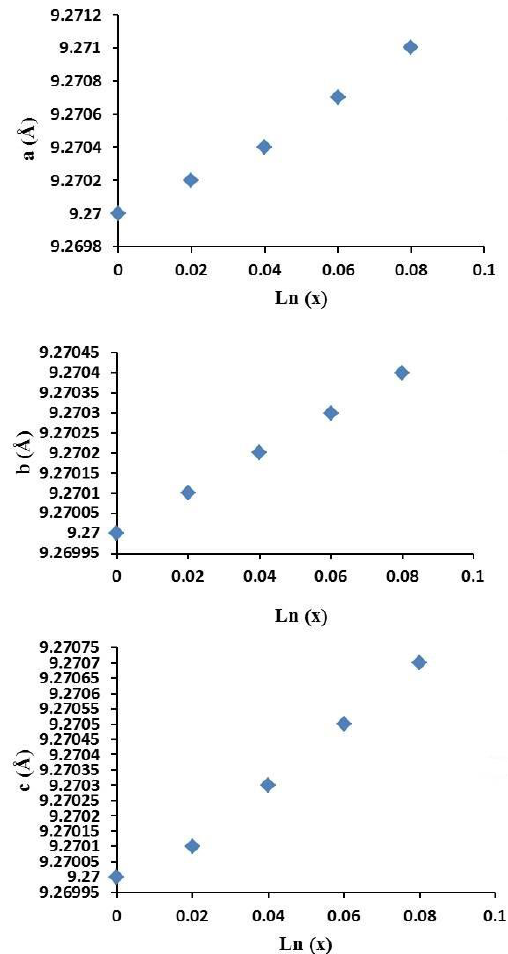
Fig. 2. The lattice constant of Dy Y O (x = 0 to 0.08) dependent x 2-x 3 upon Dy 3+ doping on Y 3+ Figure 2. The lattice constant of Dy x Y 2-x O 3 (x = 0 to 0.08) dependent upon Dy 3+ doping on Y 3+ sites.